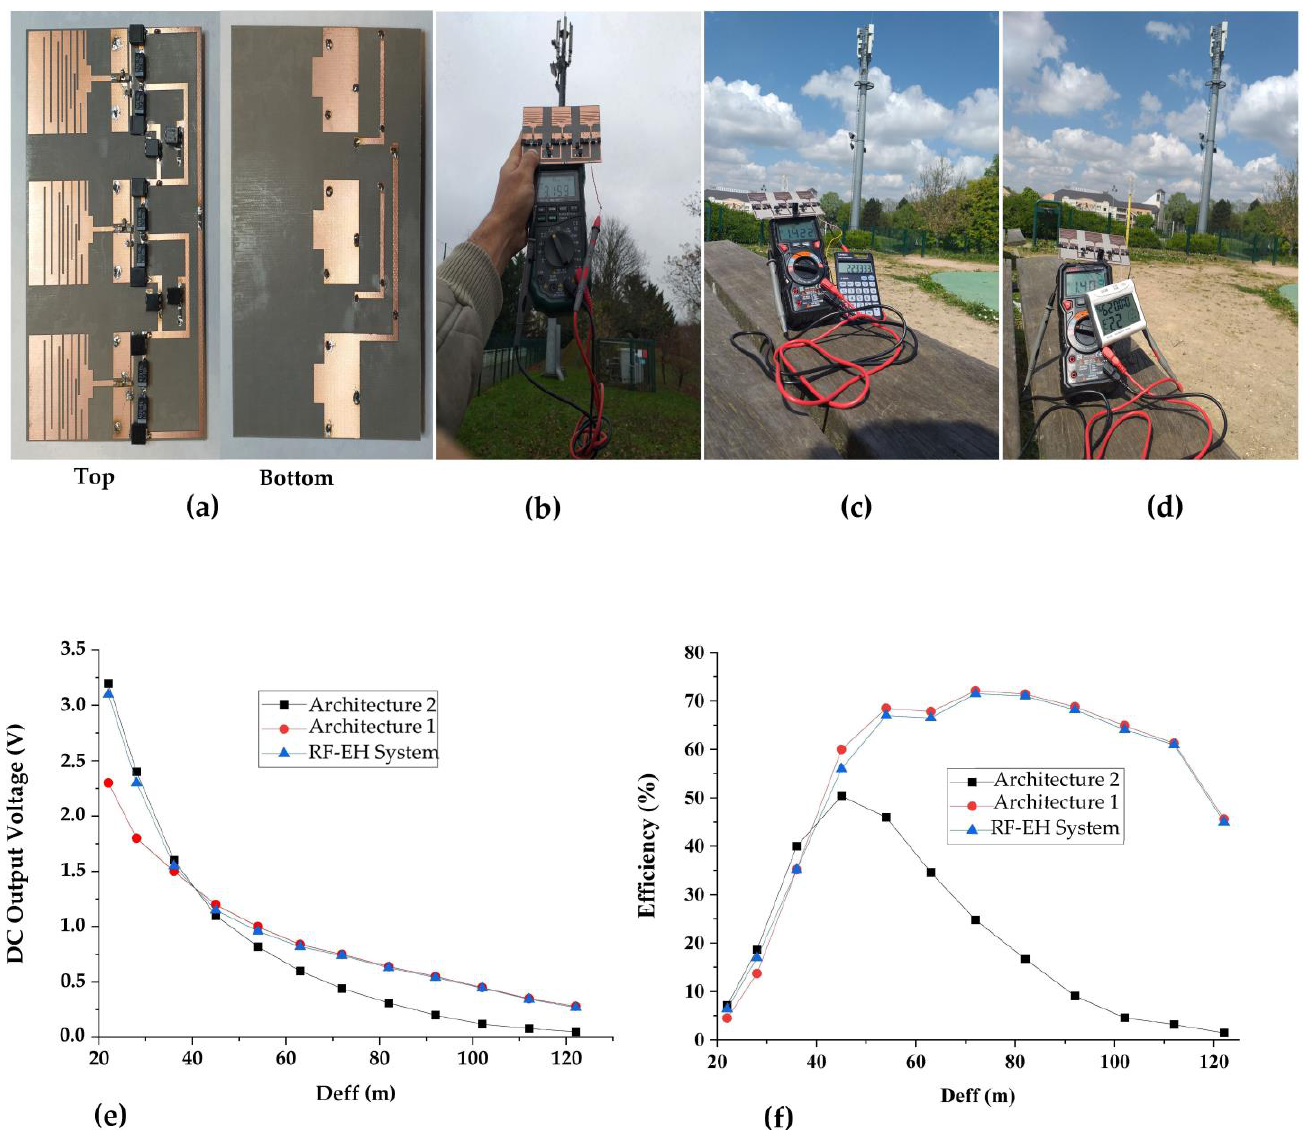
Figure 28. Measurements results: ( a ) realized proposed RF-EH system, ( b ) prototype of measure- ments, ( c ) Application of the proposed RF-EH system to feed digital calculate at 38 m from relay antenna, ( d ) Application of the proposed RF-EH system to feed temperature sensor at the same distance, ( e ) Measured DC output voltages, and ( f ) Measured RF-to-DC conversion efficiency.